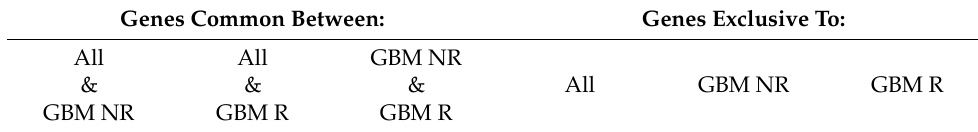
Table 3. Comparisons of the gene lists between the different analyses (All, GBM NR, GBM R) identified genes common between analyses and those exclusive to each analysis. Genes identified as potential biomarkers after further analysis are highlighted in